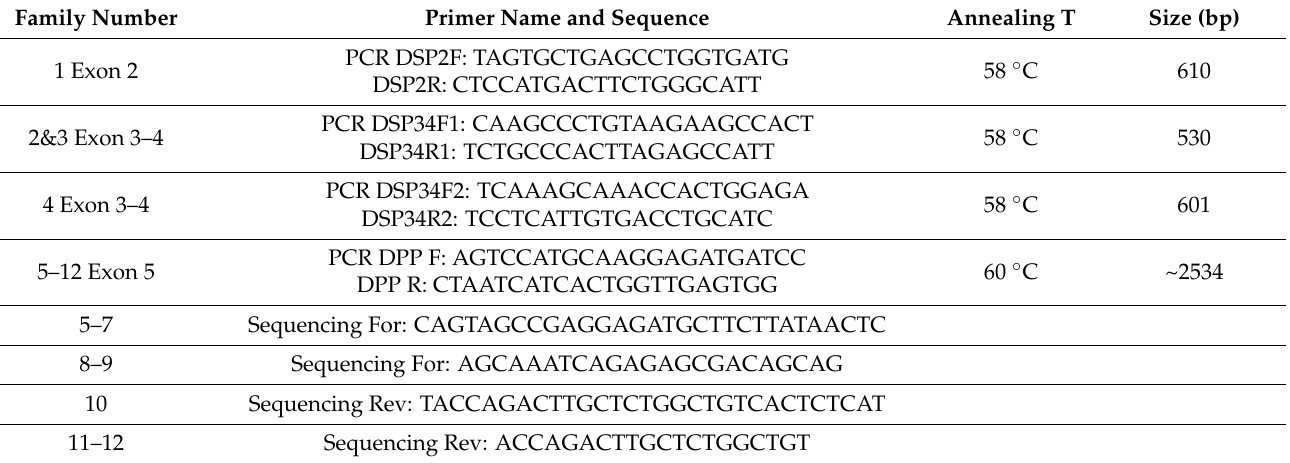
Table 4. PCR amplification primers and Sanger sequencing primers. The purified DPP amplicons were then sent for Sanger sequencing using the specific primers listed